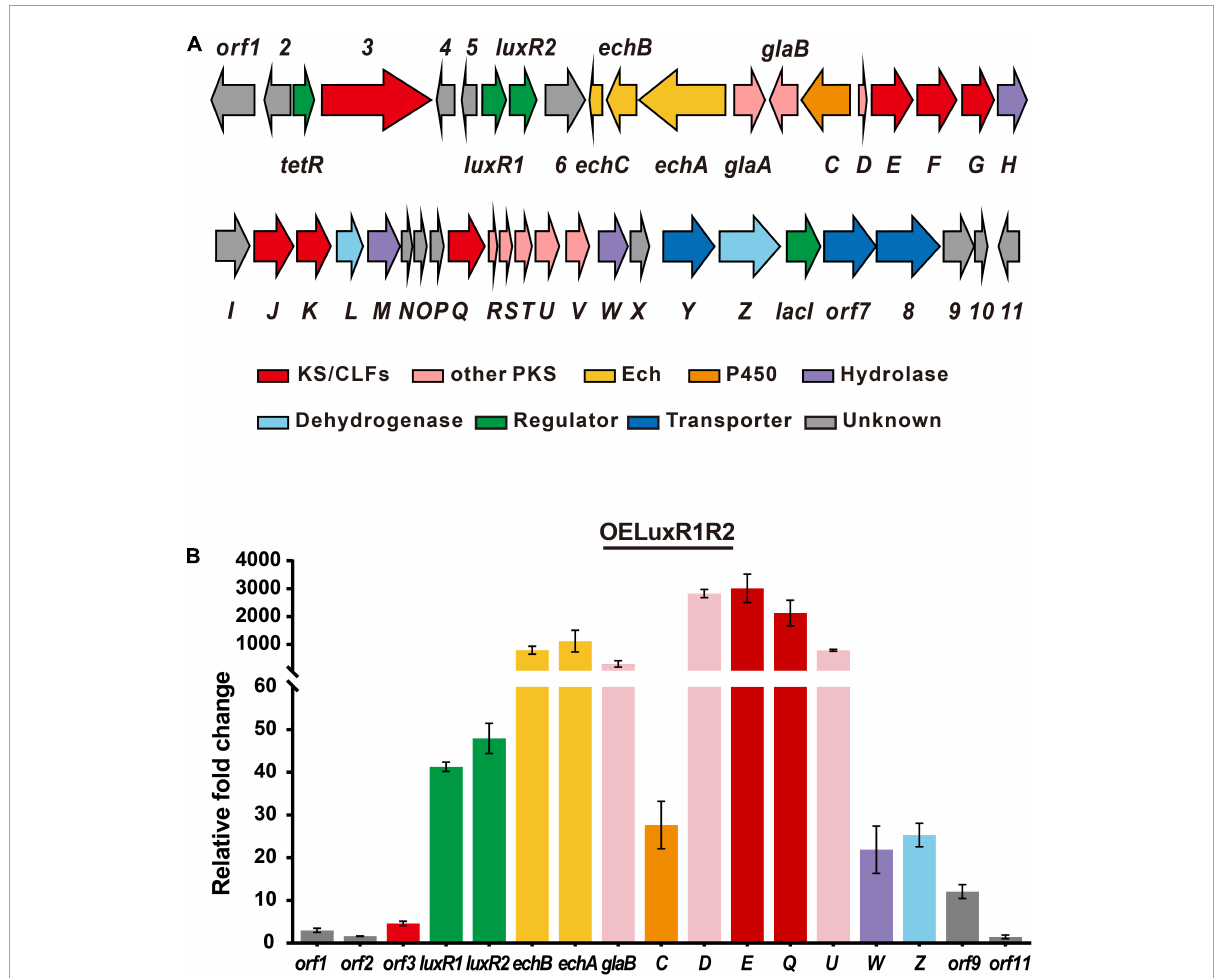
FIGURE1 LuxR1 and LuxR2 were the cluster-specific positive regulators for cluster 26. (A) Organization of cluster 26. (B) Transcriptional analysis of cluster 26 genes in the regulator-overexpression strain detected by RT-qPCR analysis. The mycelia of regulator-overexpression strain (OELuxR1R2) were collected for the extraction of total RNAs at 48 h at the beginning of the fermentation in an FMC-1027-1 medium. These samples were subjected to RT-qPCR analysis. The relative mRNA level of the target genes was normalized to the principal sigma factor gene hrdB . The relative expressional level of each sample was represented as the value related to the control strain C-1027/pSET152. Values are presented as means ± SEM (three biological repeats for each